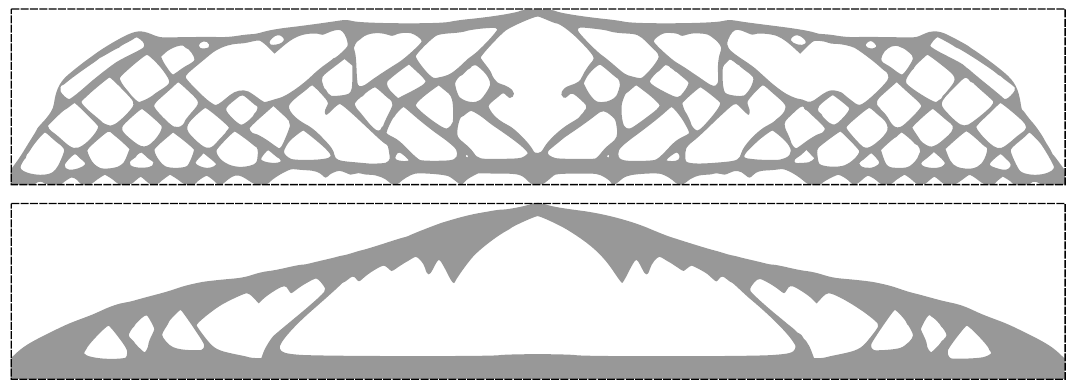
Fig. 4 Optimized shapes resulting from Problem (9) in the two-dimensional MBB Beam example, using (top) ϕ ≡ ϕ a and the threshold angle ν = 45° , and (bottom) ϕ ≡ ϕ p and the pattern functions ψ i defined in